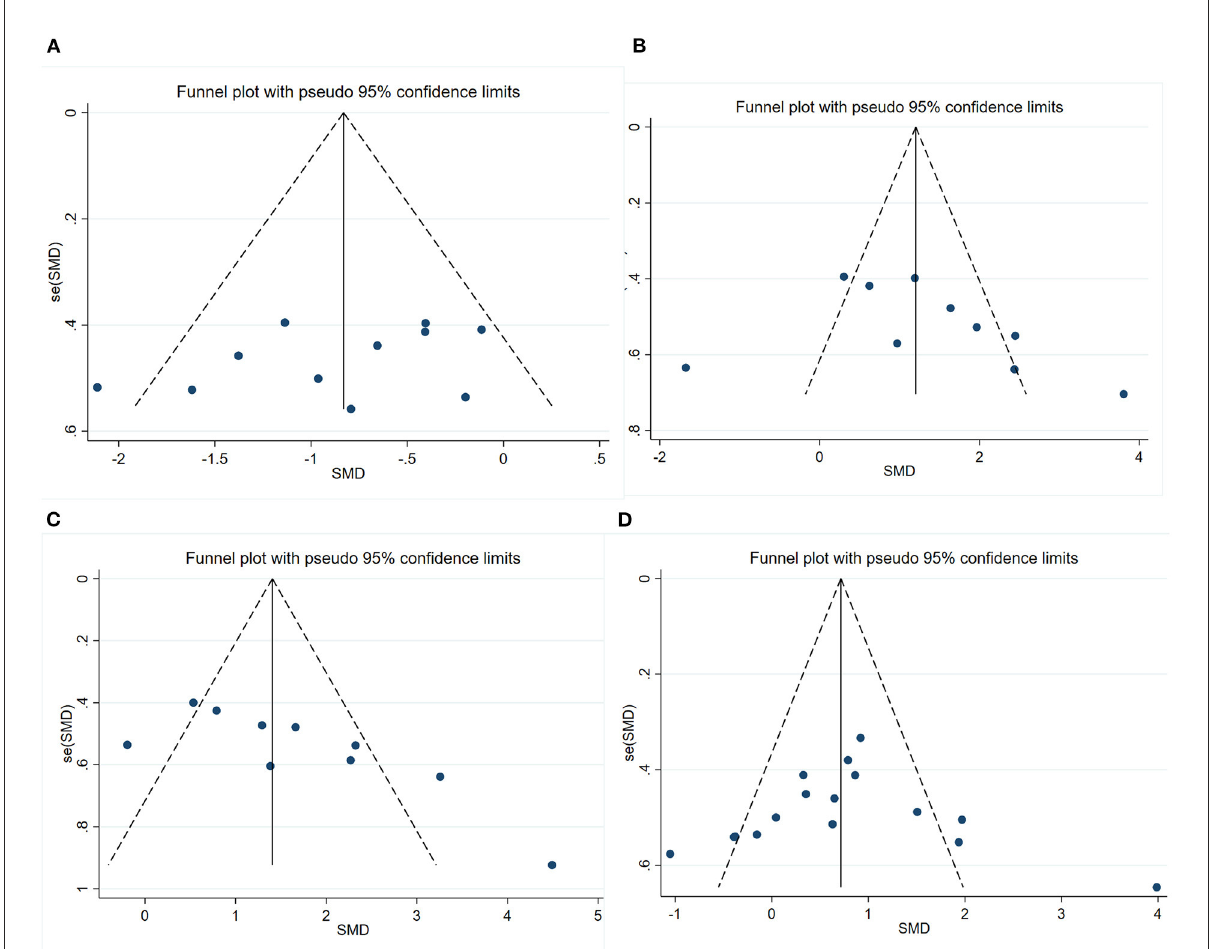
FIGURE6 Funnel plots showing the effect of exercise on cognitive function and synaptic plasticity in AD models. (A) Funnel plot for the effect of exercise on the escape latency of MWM. (B) Funnel plot for the effect of exercise on the number of platform crossings of MWM. (C) Funnel plot for the effect of exercise on the time in the target quadrant of MWM. (D) Funnel plot for the effect of exercise on the expression of